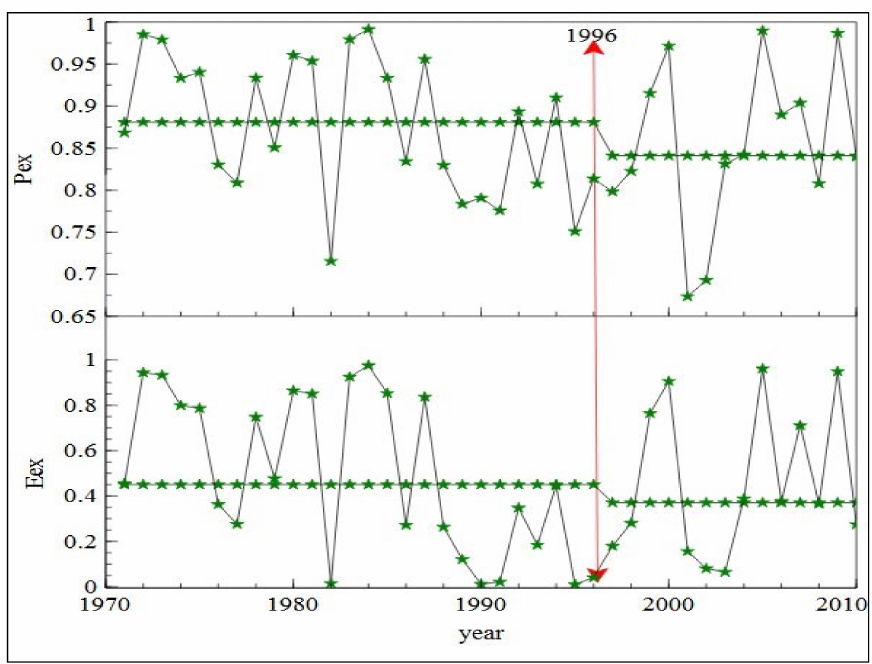
Figure 11. Eco-hydrological approach applied to the